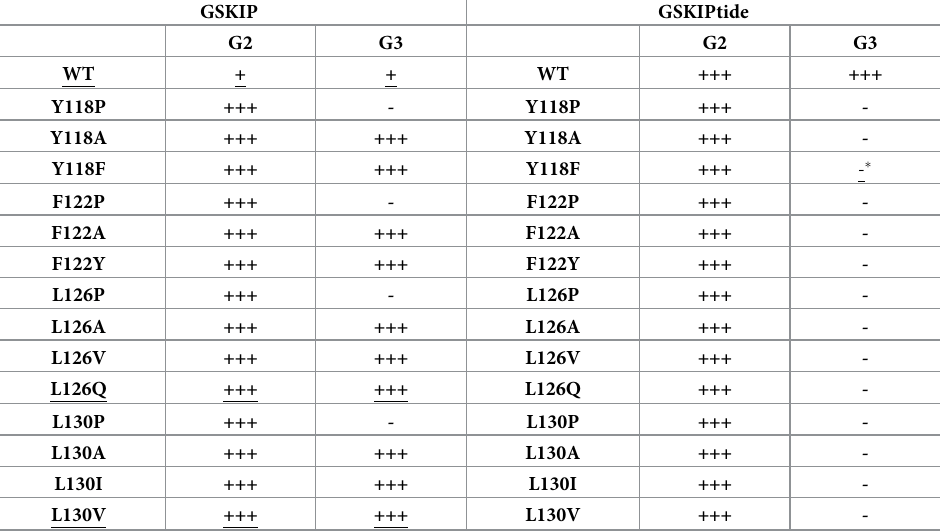
Table 1. Mutagenesis assay of the pre-GSK3 β -binding site (118F or 118Y) and various mutant GSK3 β -binding sites of full-length GSKIP and GSKIPtide (115–139). GSKIP GSKIPtide G2 G3 G2 G3 WT + + WT +++ +++ Y118P +++ - Y118P +++ - Y118A +++ +++ Y118A +++ - Y118F +++ +++ Y118F +++ - � F122P +++ - F122P +++ - F122A +++ +++ F122A +++ - F122Y +++ +++ F122Y +++ - L126P +++ - L126P +++ - L126A +++ +++ L126A +++ - L126V +++ +++ L126V +++ - L126Q +++ +++ L126Q +++ - L130P +++ - L130P +++ - L130A +++ +++ L130A +++ - L130I +++ +++ L130I +++ - L130V +++ +++ L130V +++ - The β -galactosidase filter assay was also used for semiquantitative analysis. (+) indicates positive interaction, (–) indicates the interaction is abolished, and (+++) indicates a strong interaction. The red lines indicate the pre-GSK3 β -binding site and various GSK3 β -binding sites. � Data are comparable to those of Hundsrucker et al., 2010